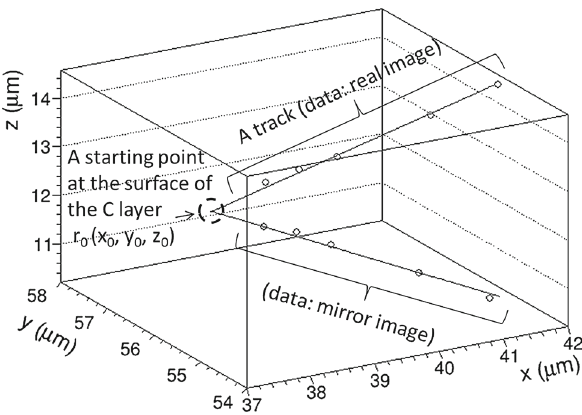
Fig. 6 An example of 3-dimensional position data of grains forming an α -track and its mirror image standard deviation of the residual errors between grain posi- tions and a fitting line in the x and y directions. The variable b in (3) is that of the z